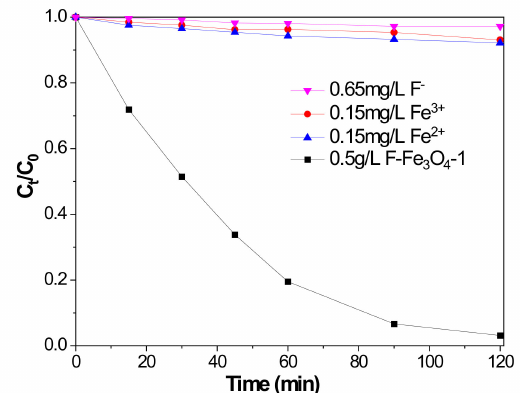
Figure 5. Catalytic degradation of OG (0.1 mM, pH 6.5) with H 2 O 2 (40 mM) after replacing 0.5 g/L of F-Fe 3 O 4 -1 with 0.65 mg/L of F − or 0.15 mg/L of Fe 2+ (or Fe 3+ ).